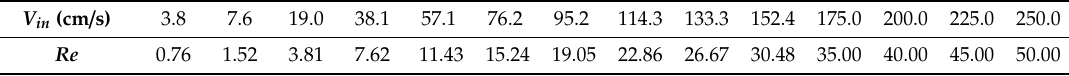
Figure 6. Simulation domain with tapered microposts (dimensions in 10 − 2 m). Table 3. Inlet velocities at different Reynolds numbers.